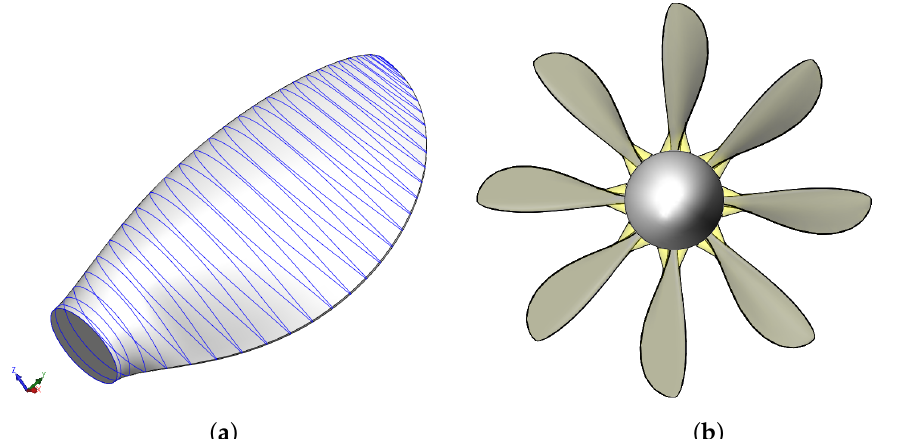
Figure 4. Comparison between original and modified propellers: ( a ) modified blade geometry, which is blended to a circular cross-section at root; ( b ) highlighted areas indicate difference in design visible from planform